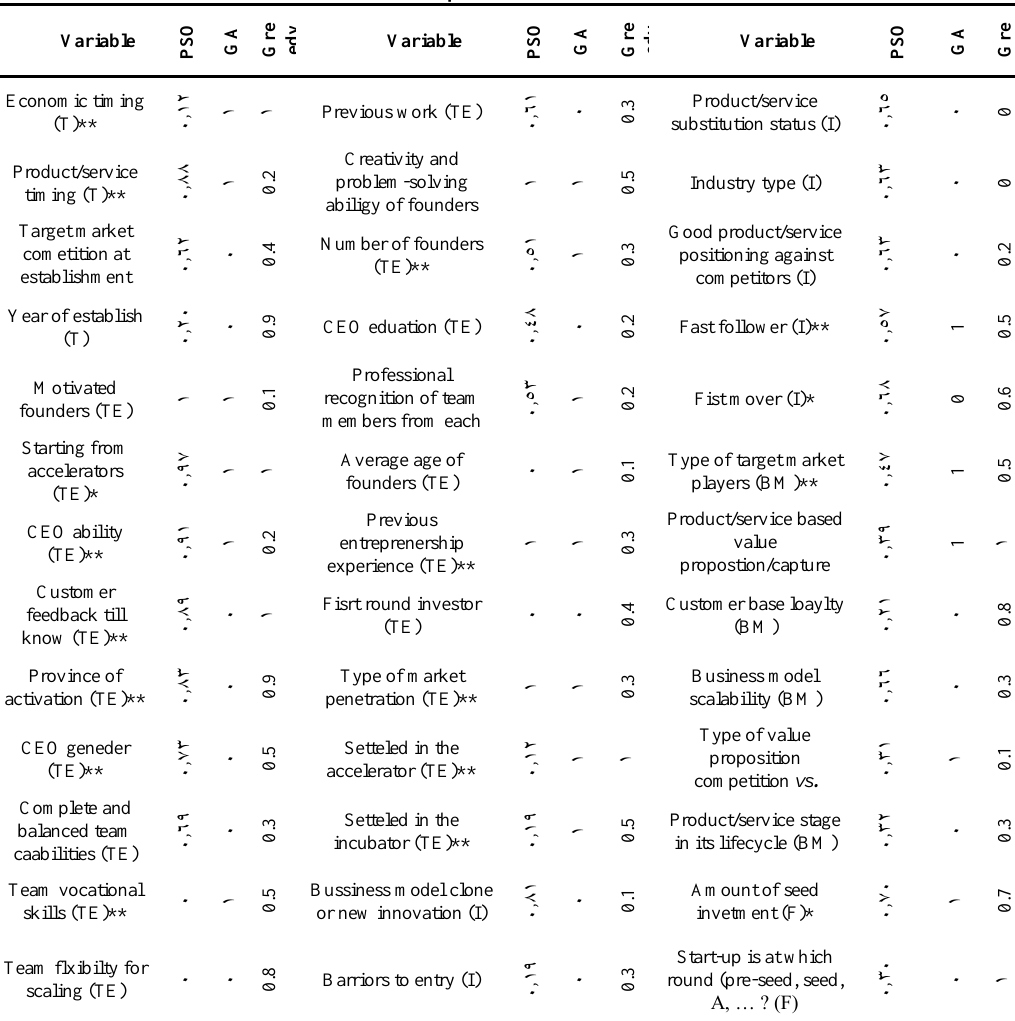
Table 2. The weight results for PSO, GA, and greedy; and variable affiliations to Gross categories are also shown in